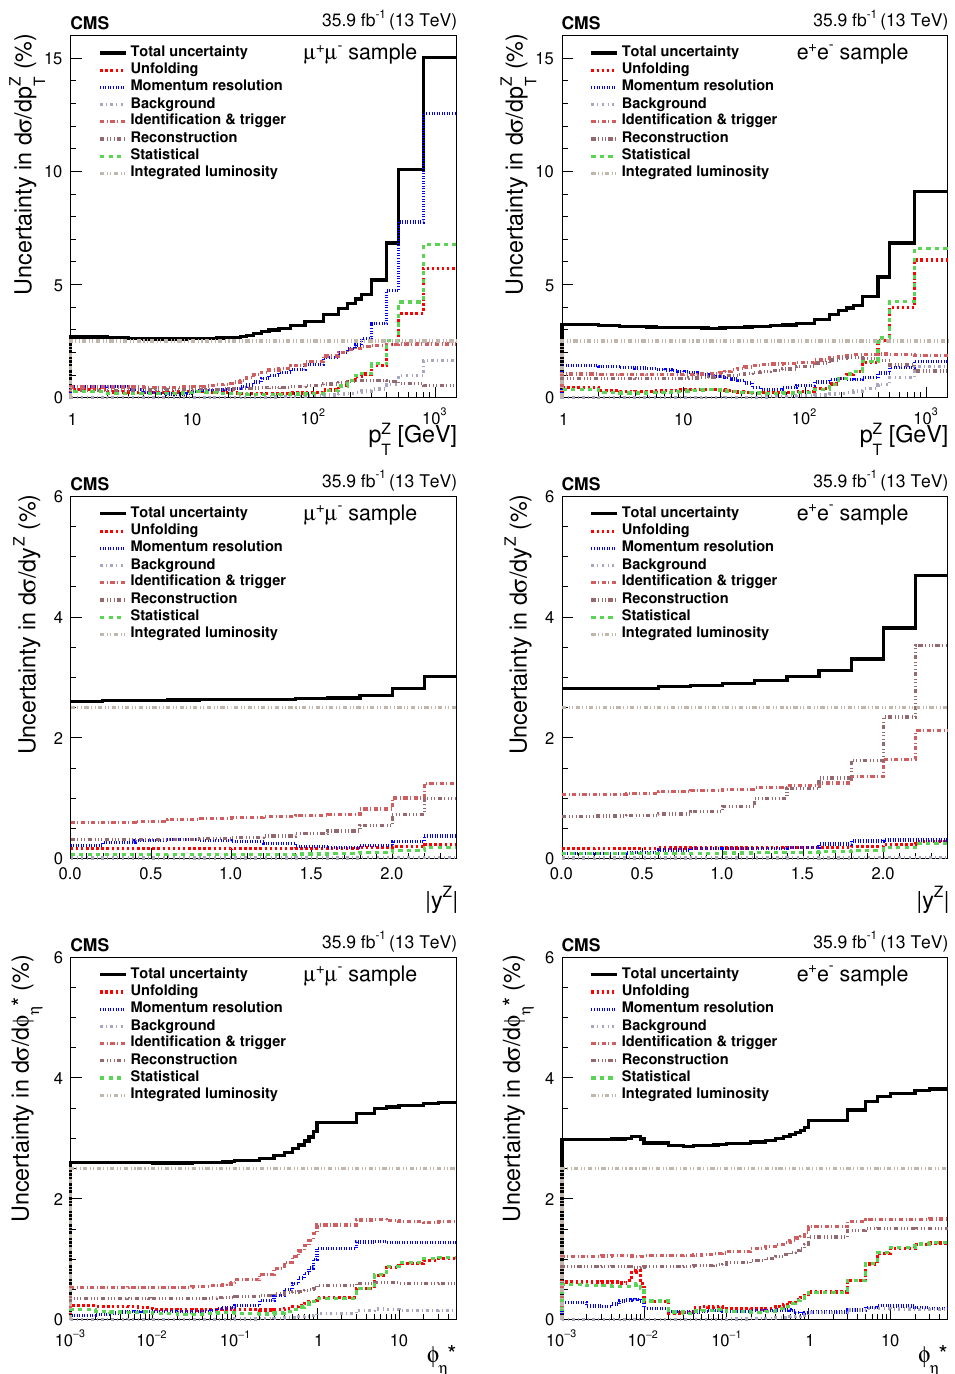
Figure 1 . The relative statistical and systematic uncertainties from various sources for the absolute cross section measurements in bins of p Z (upper), j y Z j (middle), and (cid:30) (cid:3) (lower). The left plots (cid:17) T correspond to the dimuon (cid:12)nal state and the right plots correspond to the dielectron (cid:12)nal state. The uncertainty in the trigger e(cid:14)ciency is included as part of the lepton identi(cid:12)cation uncertainty.